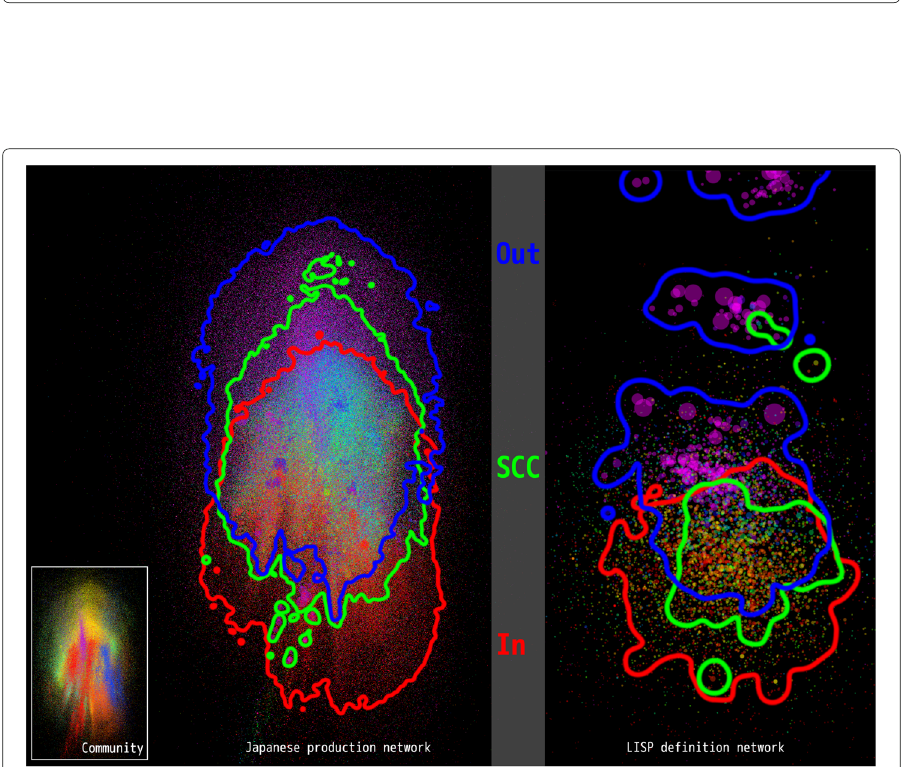
Fig. 9 Bow-tie structure exists in Japanese production network and Emacs LISP network as their global features. IN, SCC and OUT segments’ locations are shown by blue, green and red lines. Link direction upward, main plate colored to incoming link share like Fig. 5. Lower left inset shows community detection